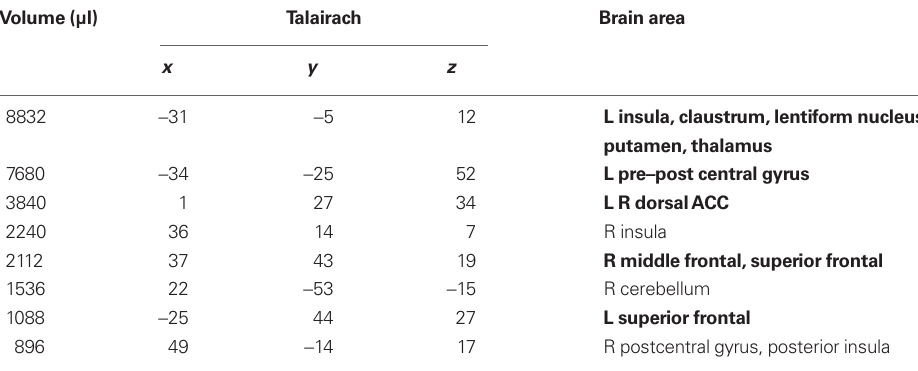
Regions that are also active in the contrast looming > standard disc are highlighted in